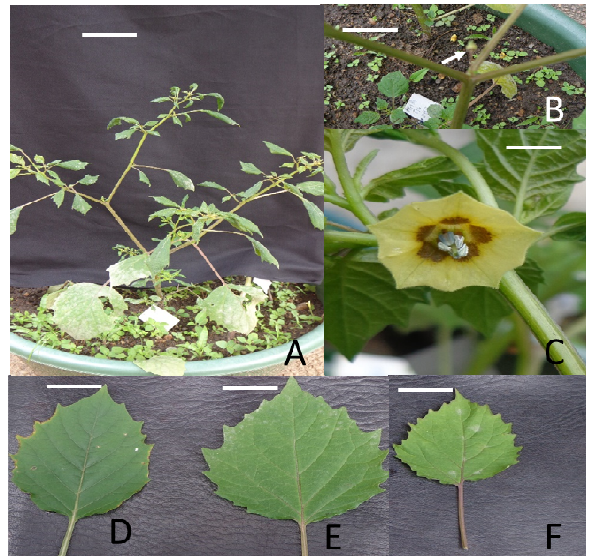
Fig. 2. F Hybrid between P. angulata x P. pubescens A. The habit of the F hybrid plant (Scale = 8 cm); B. Fertilized ovary which 1 1 slightly enlarged and later dropped after few days (arrowed) (Scale = 3 cm); C. Flower of the hybrid plant (Scale = 0.25 cm); D. Leaf of P. angulata ; E. Leaf of F hybrid plant; F. Leaf of P. pubescens (all Scale = 2 cm) 1